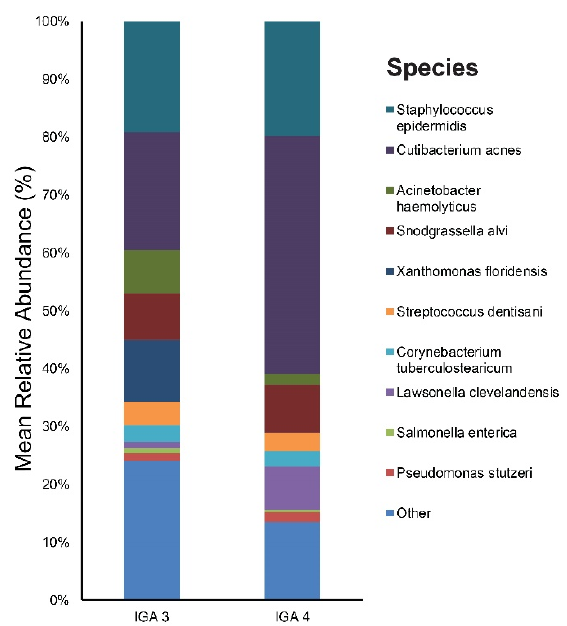
Figure 7. Bar graph on baseline skin microbiota according to acne severity (IGA 3 and IGA 4), IGA, Investigator’s Global Assessment.